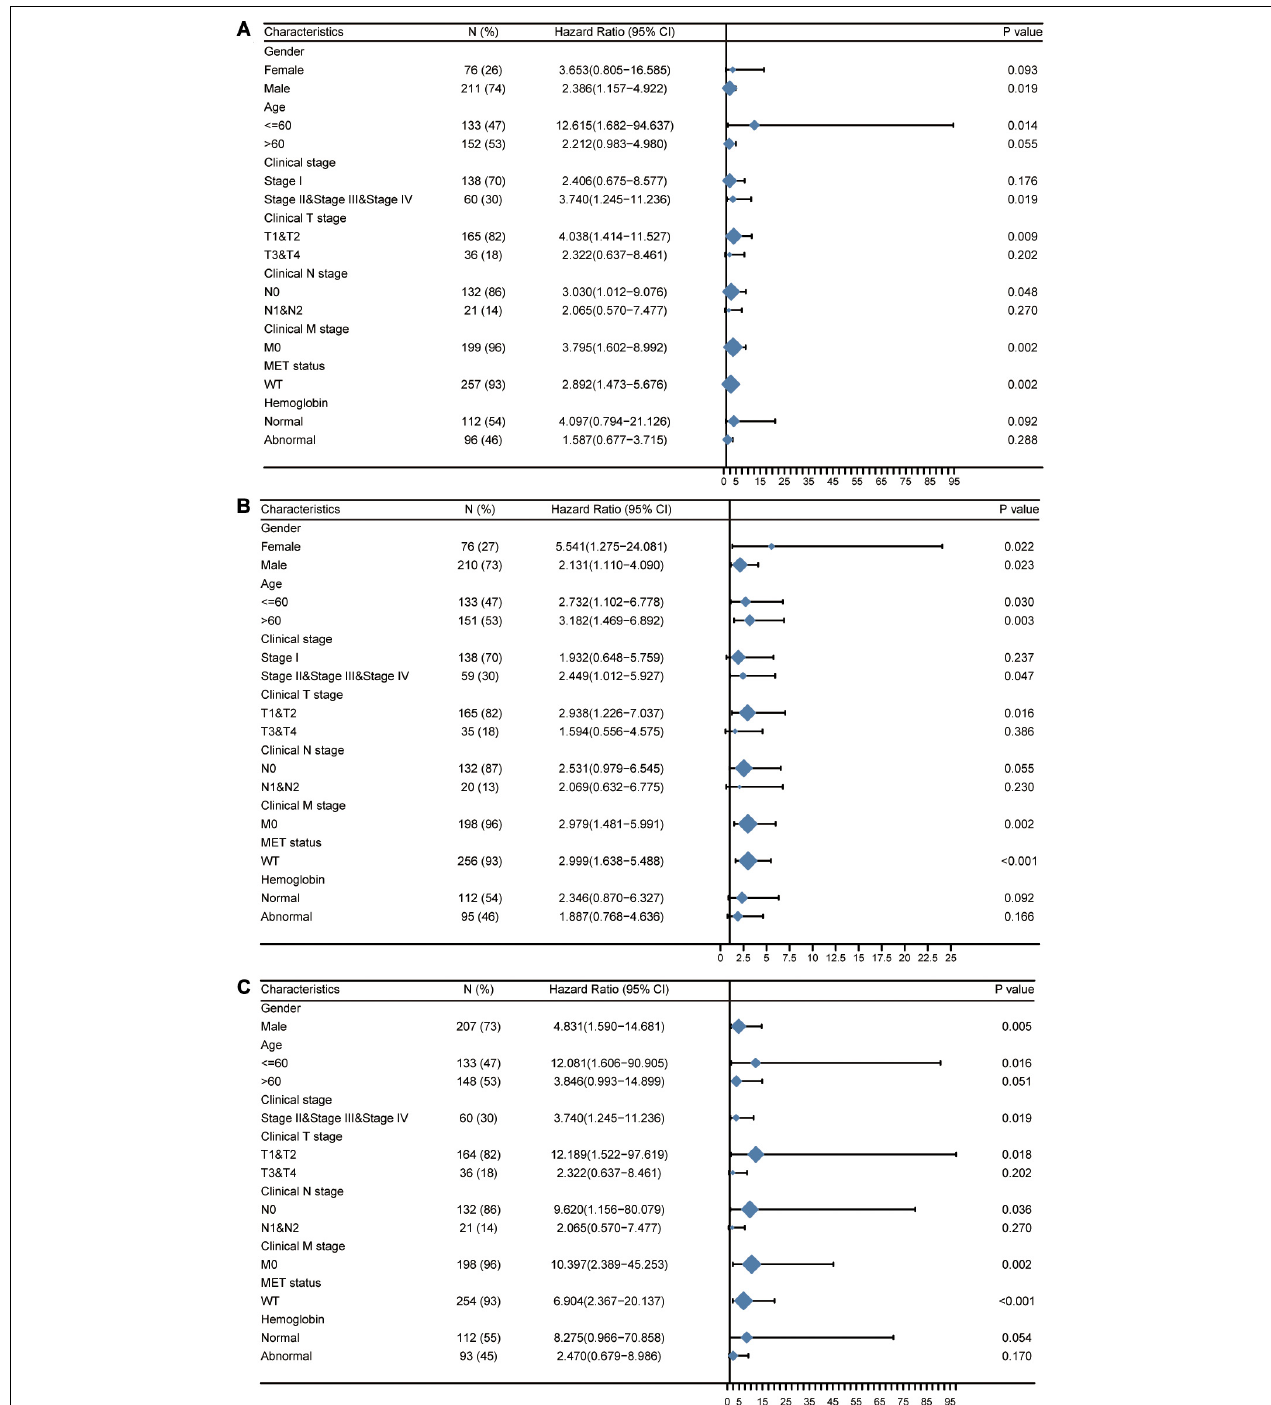
FIGURE 7 | Prognostic performance of TICRR on clinical outcomes in different papillary renal cell carcinoma (PRCC) patient subgroups. Patients were divided into different subgroups according to sex, age, clinical stage, clinical TNM stage, MET status, and hemoglobin level. For each subgroup, the prognostic performance of TICRR on overall survival (A) , progression-free interval (B) , and disease-specific survival (C) were evaluated by Cox regression, and the results are presented as hazard ratio. The bar represents the 95% confidence interval of hazard ratio, the diamond’s size represents the significance of TICRR ’s performance.